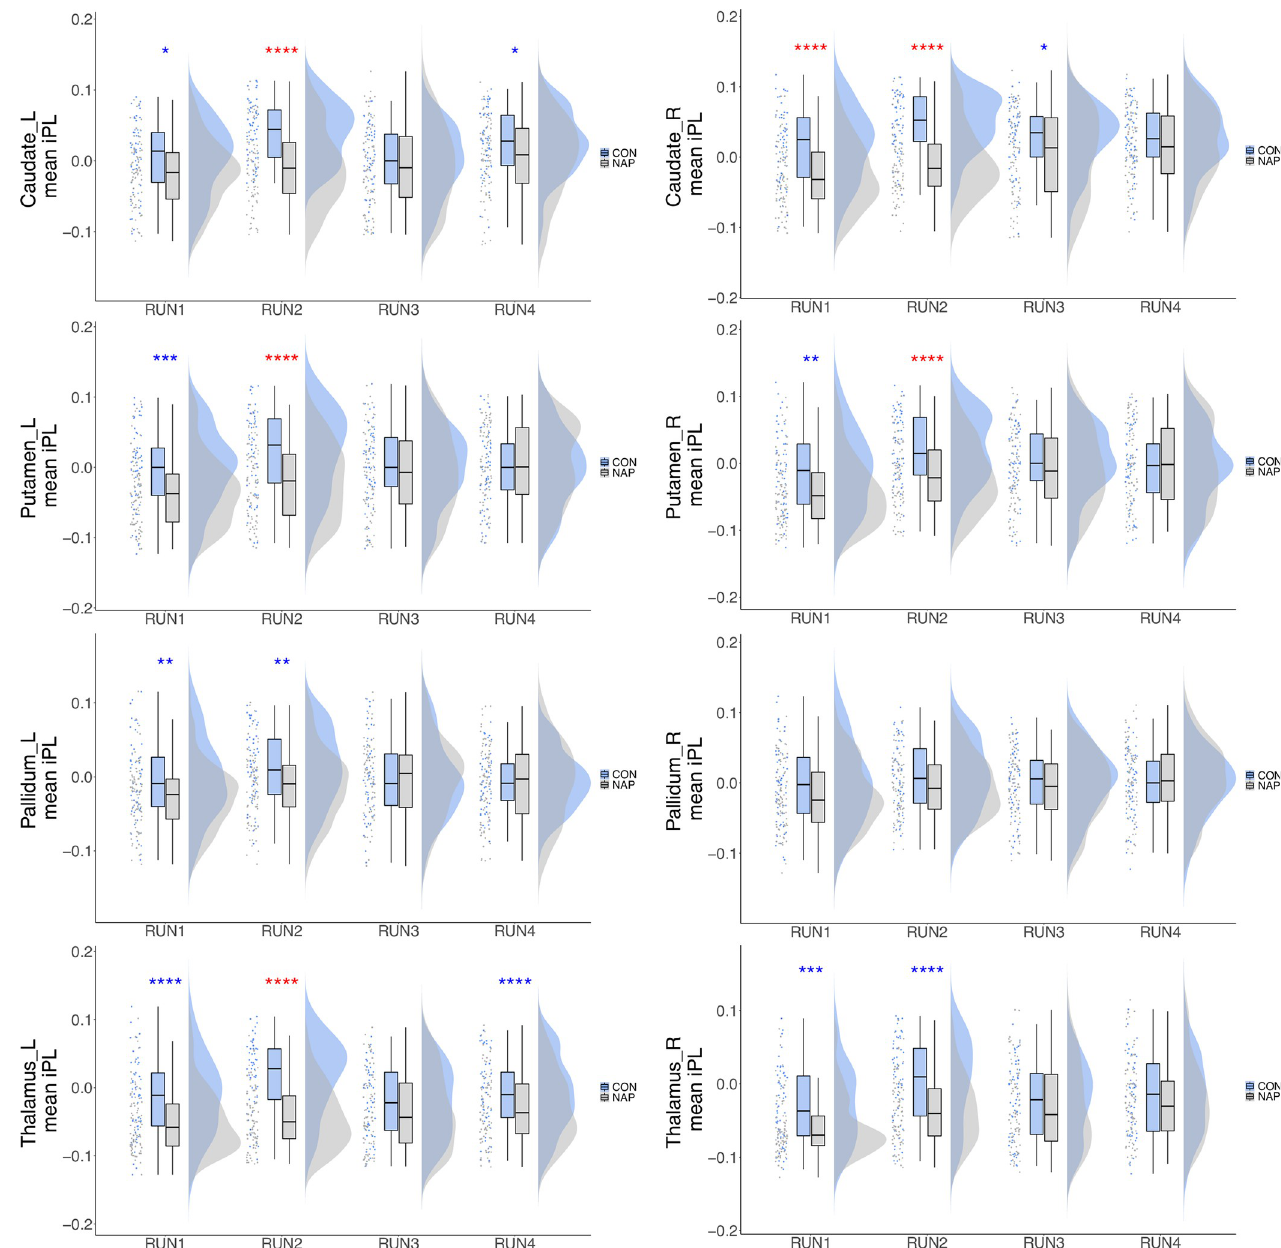
Fig 3. Group differences in regional contribution to the leading eigenvector for Mode ψ 4 . Regional contribution was calculated as the mean value of instantaneous phase-locking over time for a particular anatomical region of interest. Raincloud plots show from left to right scatter plot for the raw data, boxplots showing the median, upper and lower quartiles, upper and lower extremes, and the distributions of the raw data. iPL, instantaneous phase-locking, � = 0.05, �� = 0.01, ��� = 0.001, ���� < 0.001. Red � effect size between groups greater than effect size between runs. Blue � effect size between groups less than largest effect size between